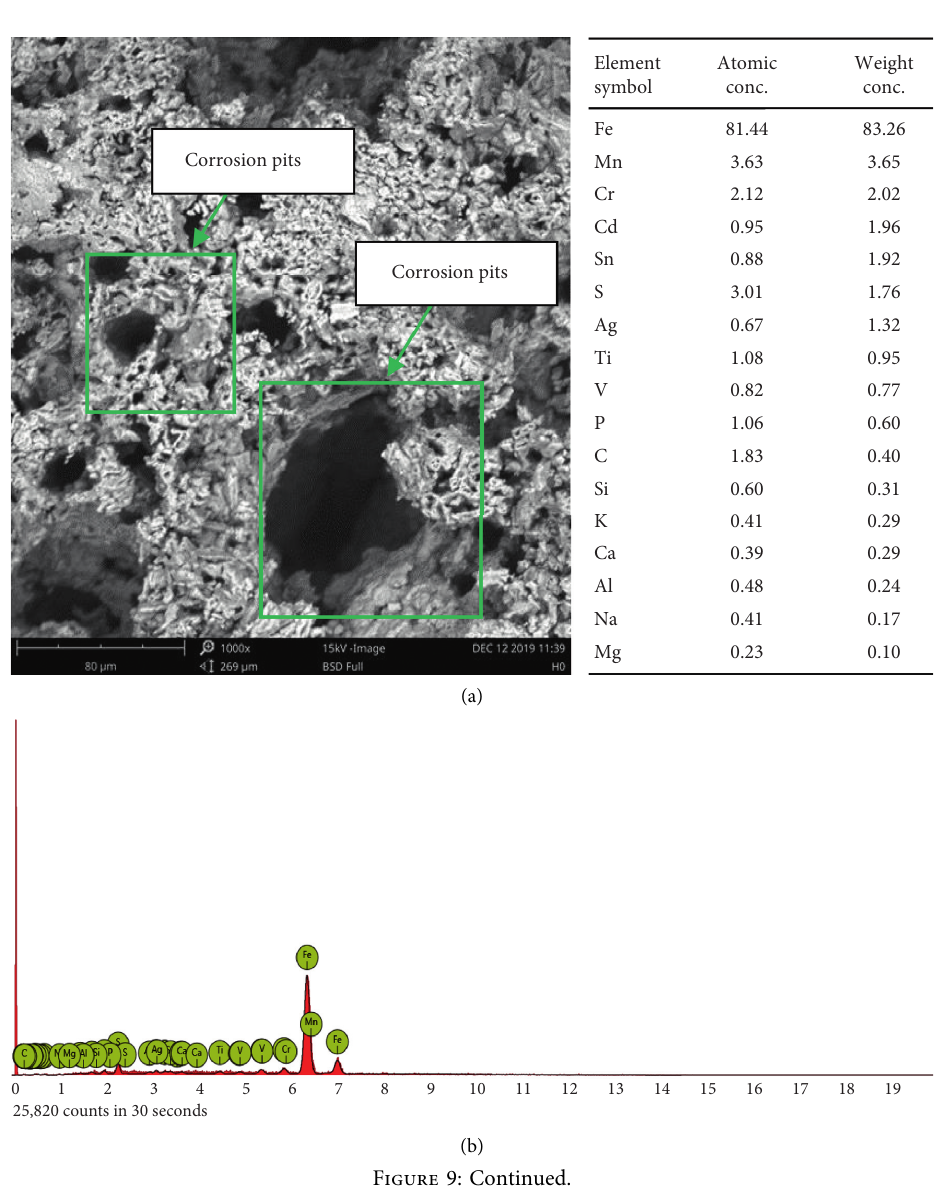
Table 5: Gibbs free energy, surface coverage, and equilibrium constant of adsorption for MBZ inhibitor in 1.5M H